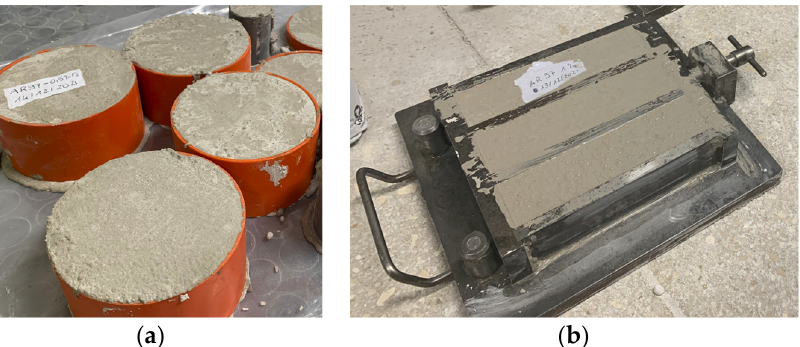
Figure 2. Molding of samples for non-destructive thermal conductivity tests ( a ); molding of samples for compression tests ( b